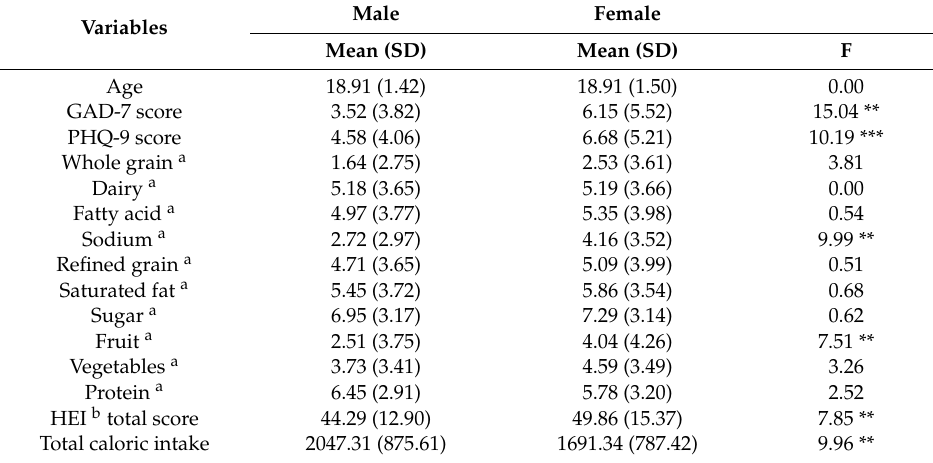
Table 2. Sex di ff erences in primary study